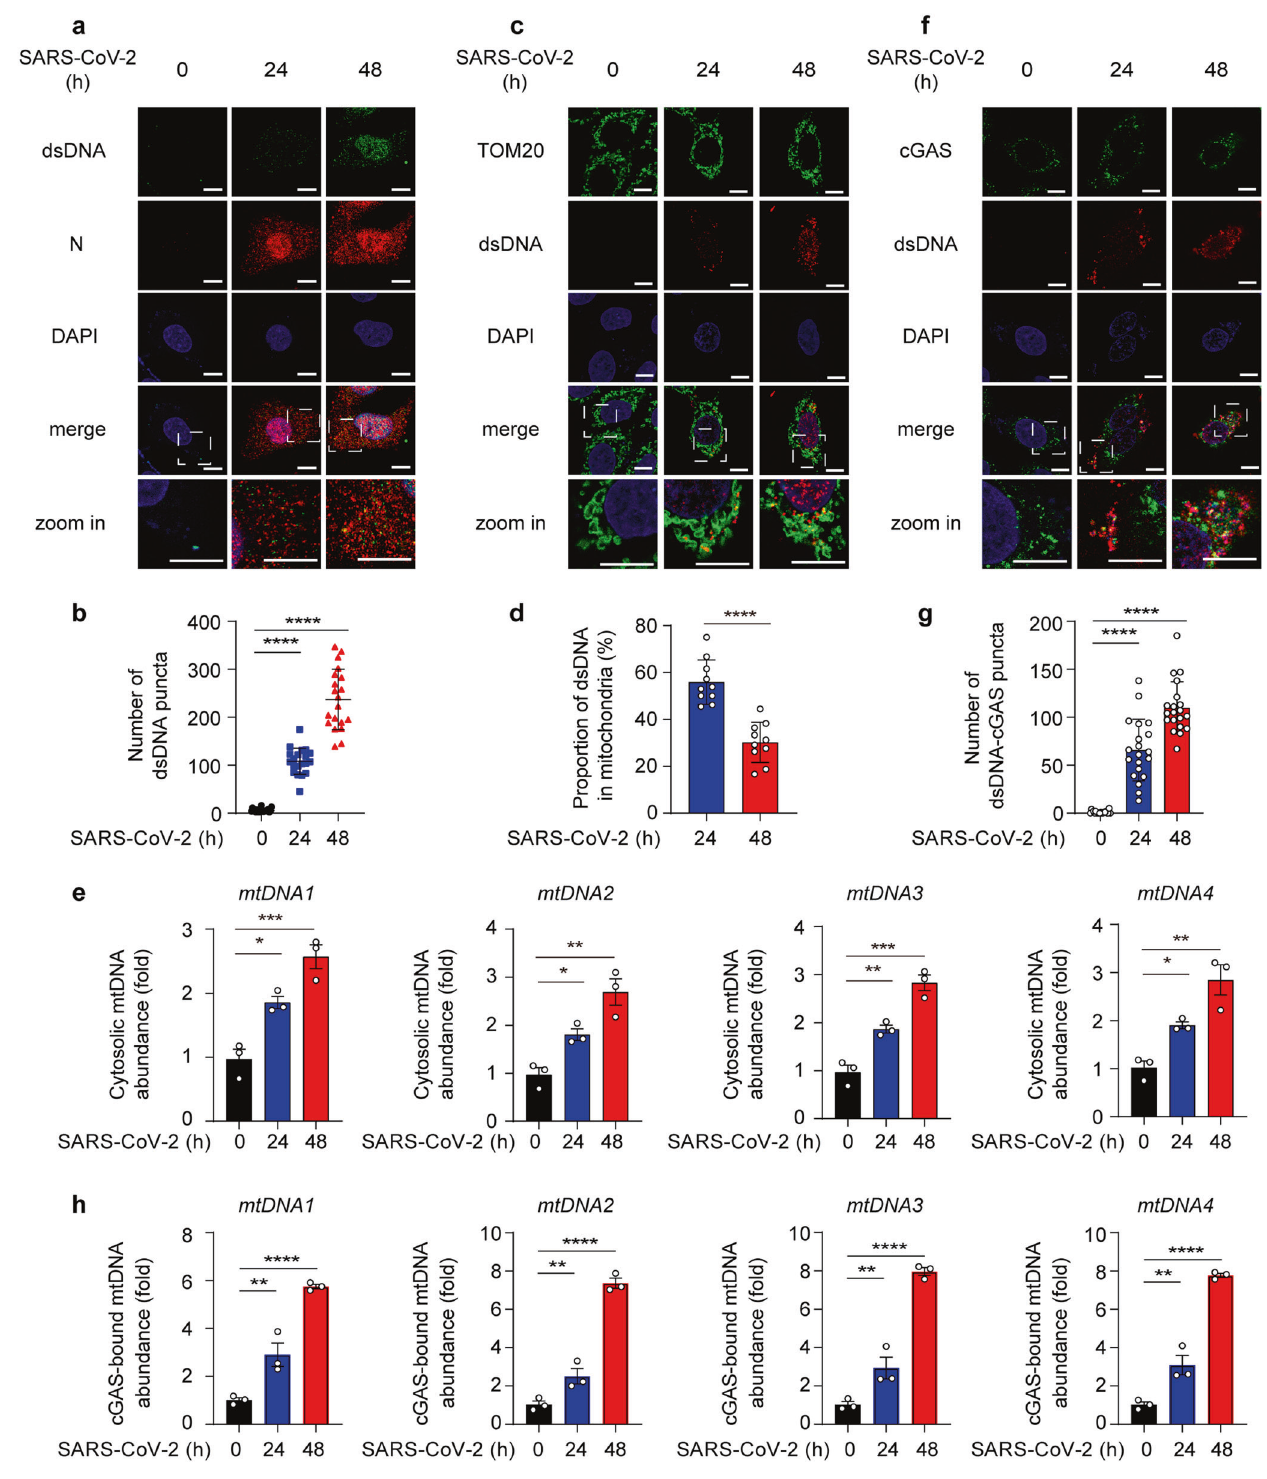
granule assembly factor 1 (G3BP1)-containing condensates, the cofactor of cGAS. 24 – 26 It provokes our attention to the antagon- isms between SARS-CoV-2 infection and cGAS-triggered IFN-I signaling. In the current study, we uncover the engagement of cGAS- mediated signaling in SARS-CoV-2-induced IFN-I by detecting cytosolic mtDNA released by damaged mitochondria. To inhibit